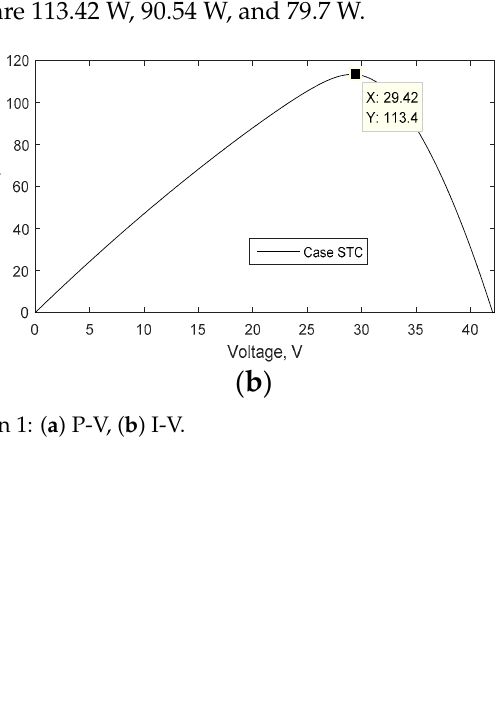
Figure 7. Characteristics of PV panel for pattern 2: ( a ) P-V, ( b ) I-V. ( a )